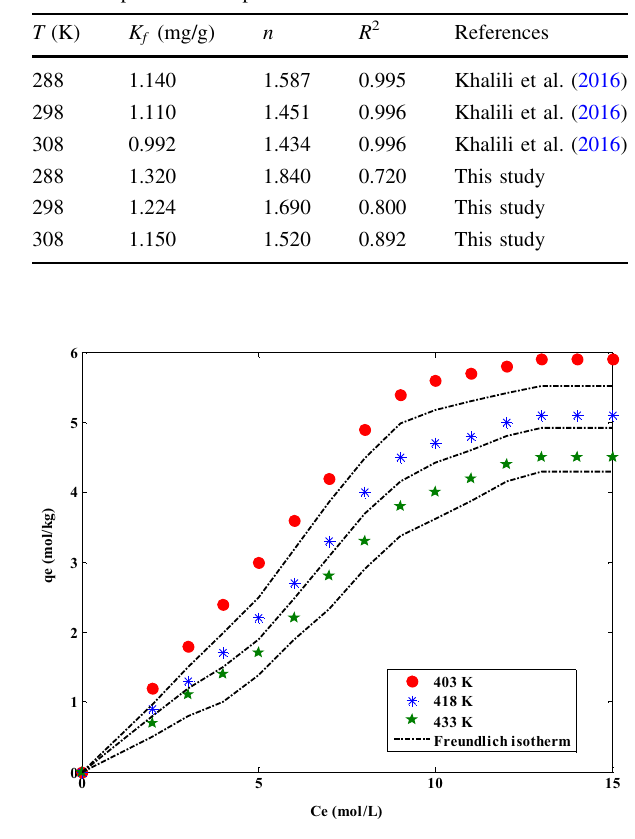
Fig. 4 CO 2 adsorption isotherms of polyaspartamide at various temperatures (experimental vs Freundlich isotherm)